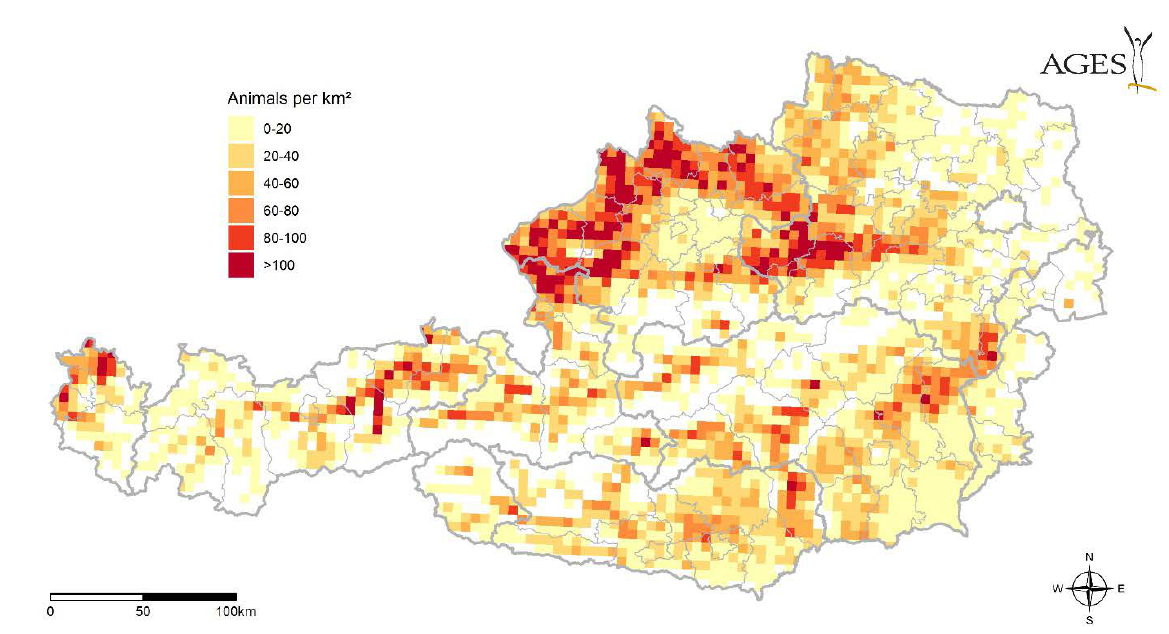
Figure 7. Large livestock animals (horses and cattle) per km 2 . (shapefile source: Verwaltungsgren- zen (VGD) ©BEV, 2021. Regional statictical grid, Statistics Austria. Data.statistik.gv.at, accessed on 1 April 2022)